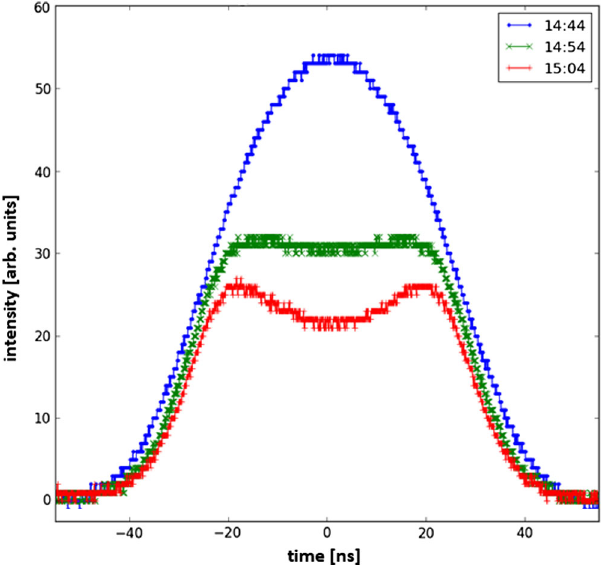
FIG. 7. Evolution of the longitudinal distribution of the ion bunch in the presence of the circular attractor.